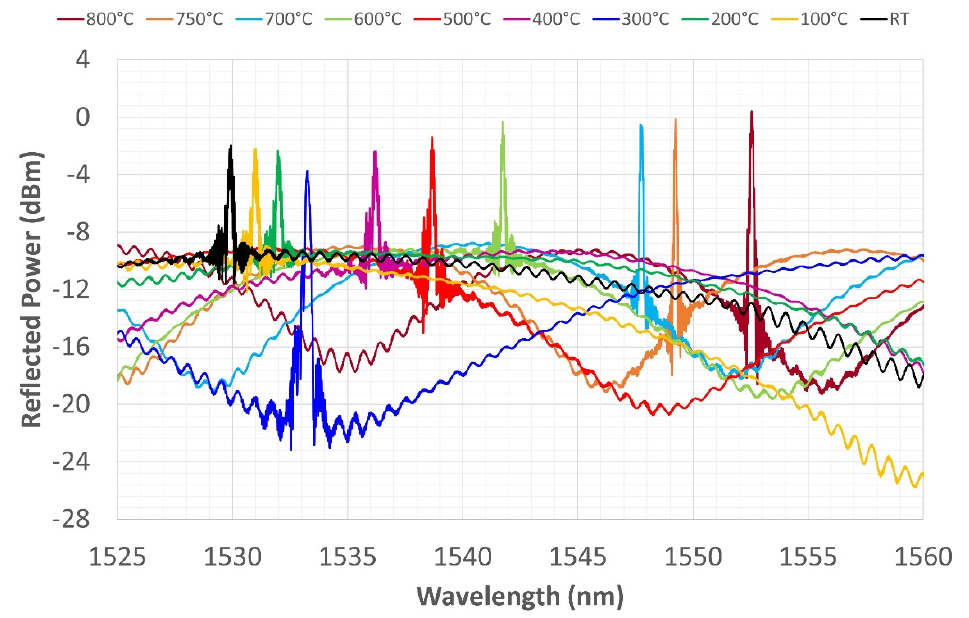
Figure 13. Third thermal cycle—grating reflected spectrum change during cooling from 800 °C to RT.